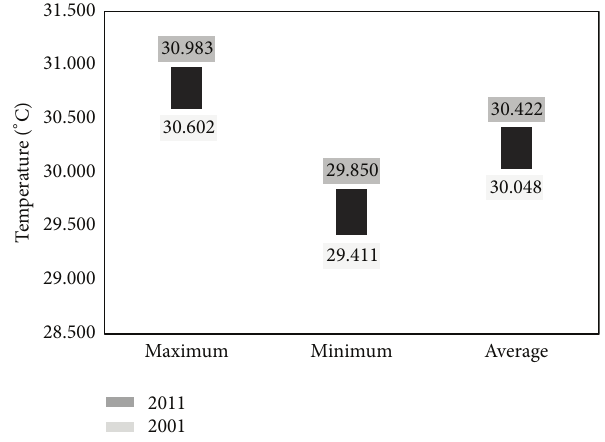
Figure 5: Changes in the surface temperature in the summers of 2001 and